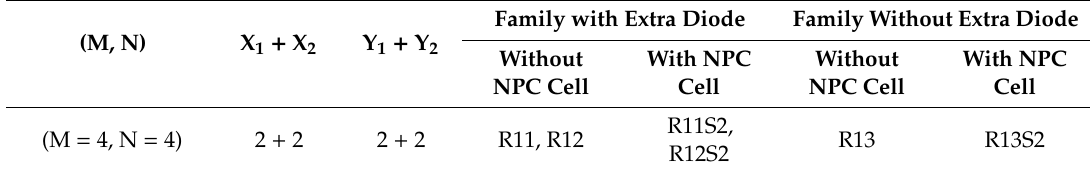
Table 4. Direction connection NPC cell under